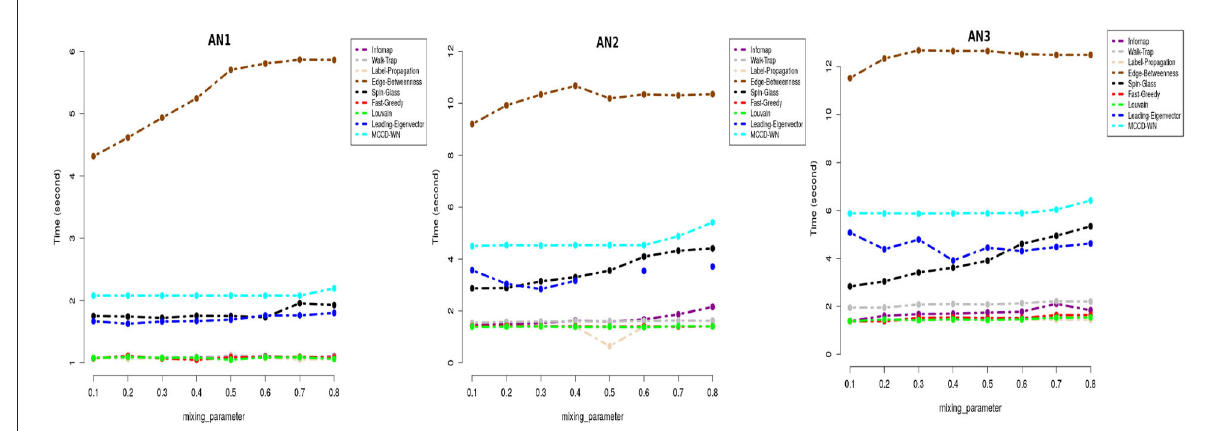
FIGURE7 Performance comparison in terms of running time (in seconds) on a log-linear scale.